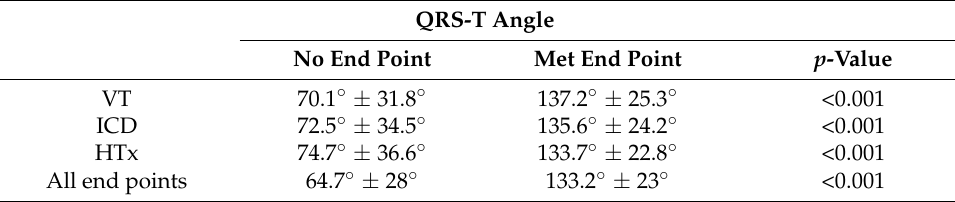
Table 2. QRS-T angle in cardiomyopathy patients according to the adverse outcome.